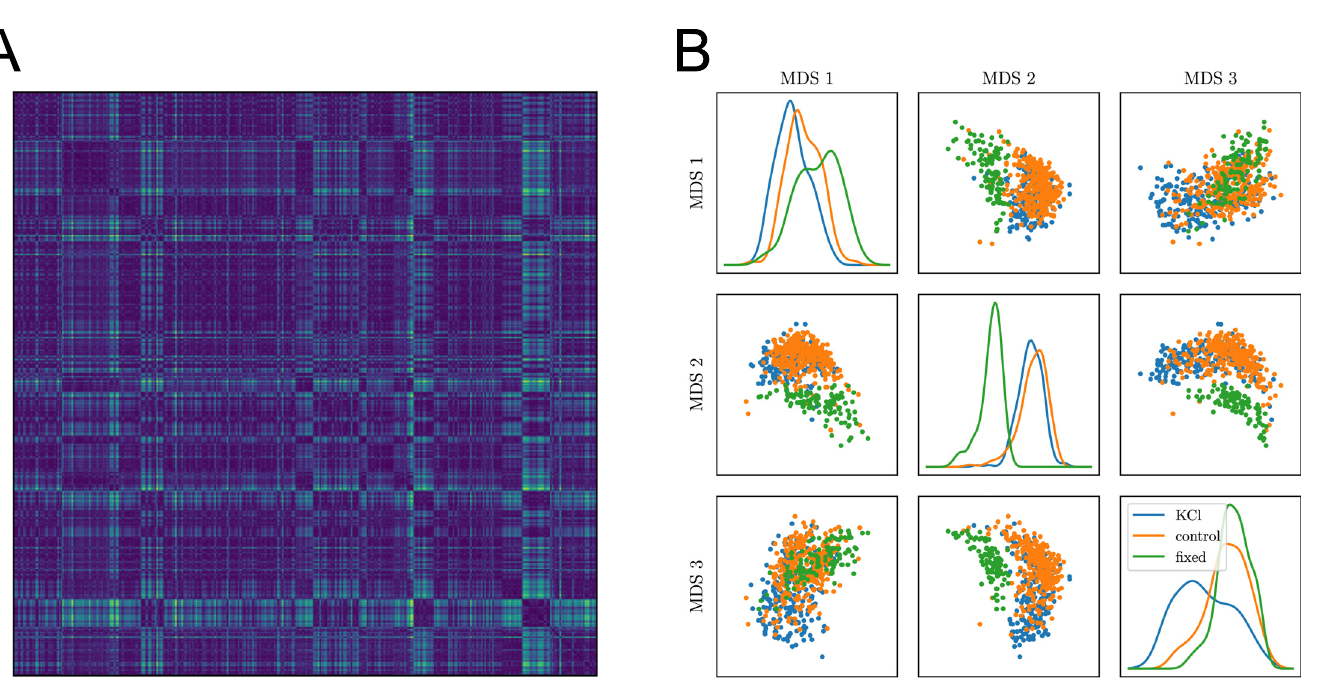
Fig 7. Comparing individual synapses. ( A ) Matrix of the inter-synapse MMD: the value at row i and column j is colored according to the MMD between trajectories of synapse i and synapse j . ( B ) three-dimensional embedding obtained by multi-dimensional scaling (MDS) based on this distance matrix. Dots are coloured according to the condition in which the synapse they represent was observed: CTRL in orange, KCl in blue and fixed in green.